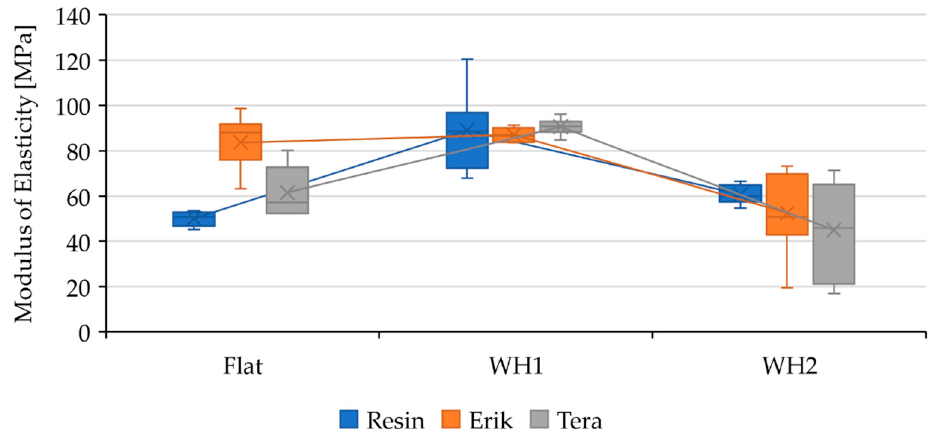
Figure 5. Evaluation of the modulus of elasticity of adhesive bonds under static loading and their dependance on the bond shape.